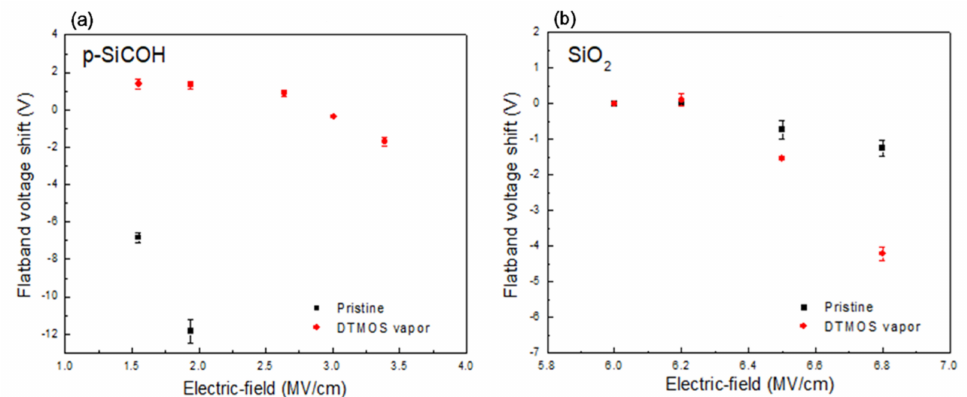
Figure 7. Flatband voltage shifts of Cu-gate MIS capacitors after being subjected to electric stress for varying fields: ( a ) p-SiOCH; ( b ) SiO 2